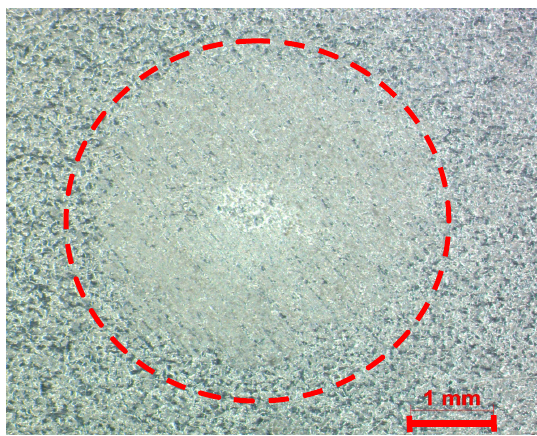
Figure 9. Image of zinc coated sheet surface after spot welding using additive manufacturing (AMSW).